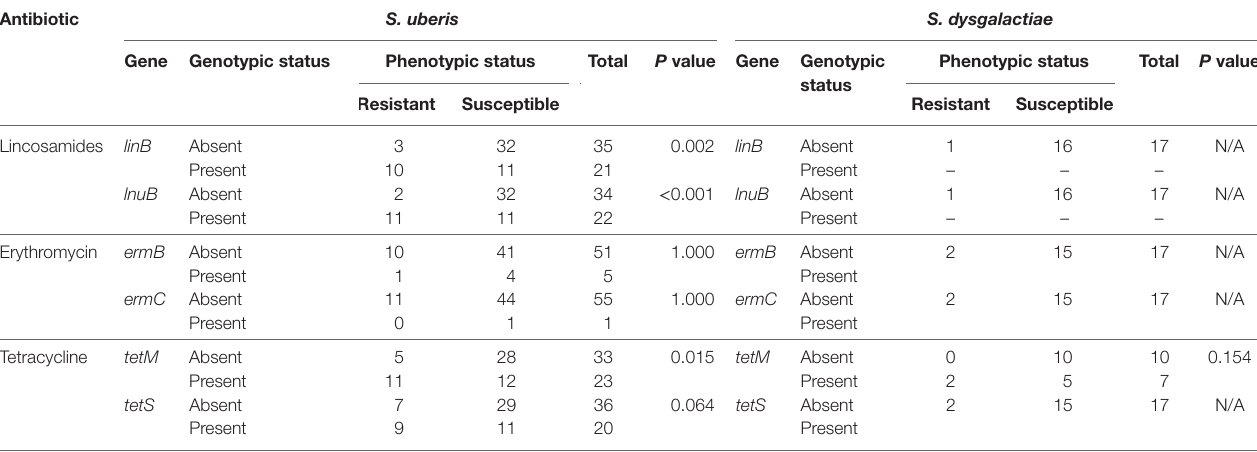
Isolates were recovered from dairy cows on 18 farms in the Maritime Provinces of Canada, 2007 and 2008. N/A, there were no observations for this combination of categories.